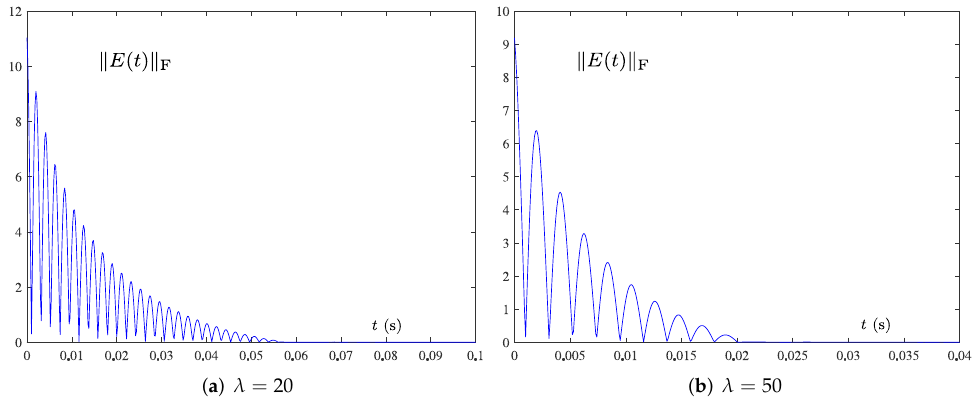
Figure 8. Simulation results under the constant periodic multiple-harmonic noise, the PTCAZNN model (39) for TVMIP of (40) with λ = 20,50